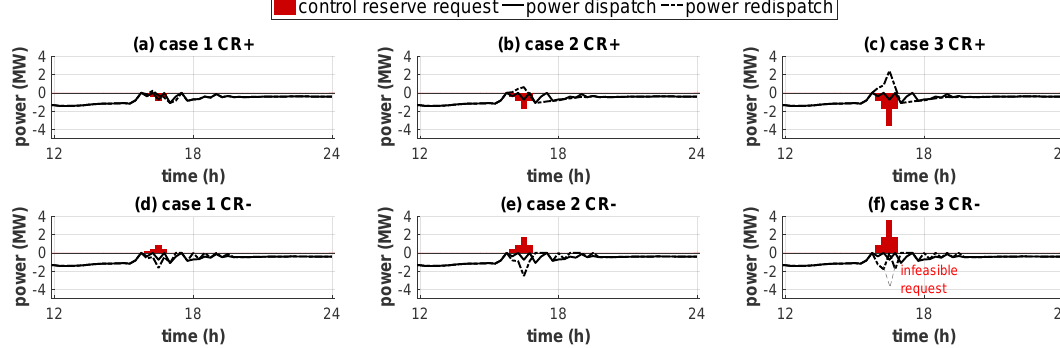
Figure 10. Response to positive and negative reserve power requests and performed redispatch measures.